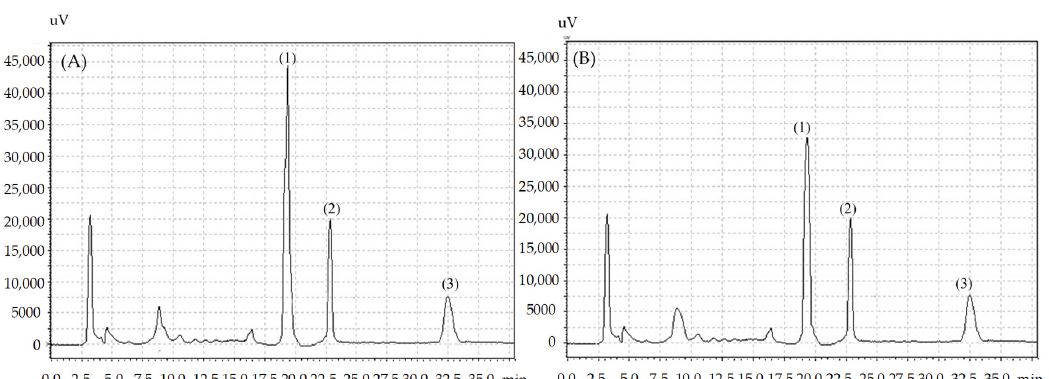
Figure 2. Chromatograms showing retention times and peak areas for flavonols in organic ( A ) and conventional ( B ) Gala apples, (1) quercetin-3- O -rutinoside, (2) kaempferol-3- O -glucoside, and (3) quercetin.